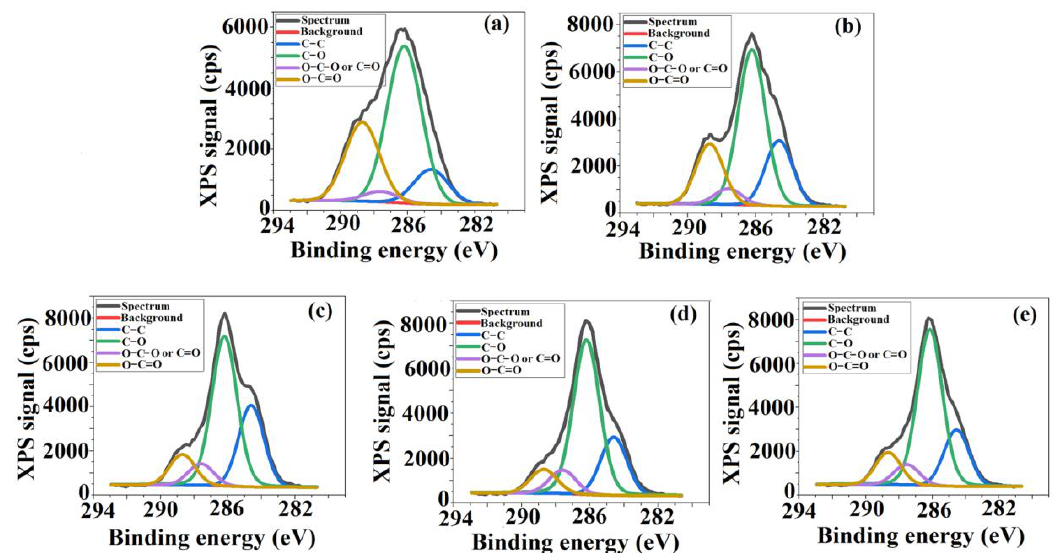
Figure 5. The deconvolution of C 1s spectra for: ( a ) CA, ( b ) CA+0.5 wt.% TEOS, ( c ) CA+1.0 wt.% TEOS, ( d ) CA+1.5 wt.% TEOS, ( e ) CA+2 wt.% TEOS films.